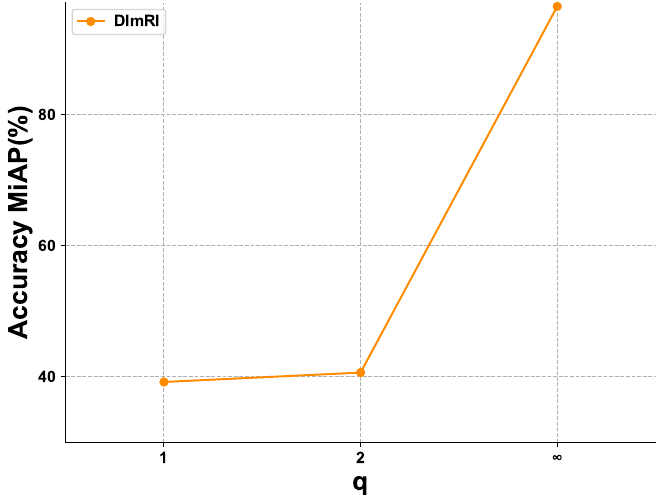
Figure 13. The figure shows the effect of q about MiAP score which using our